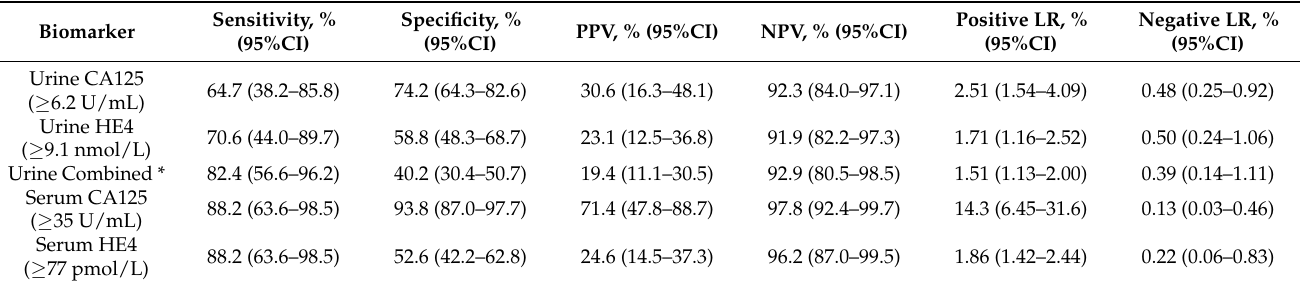
Table 3. Diagnostic performance of serum and urine CA125 and HE4 for the detection of epithelial ovarian cancer at specified